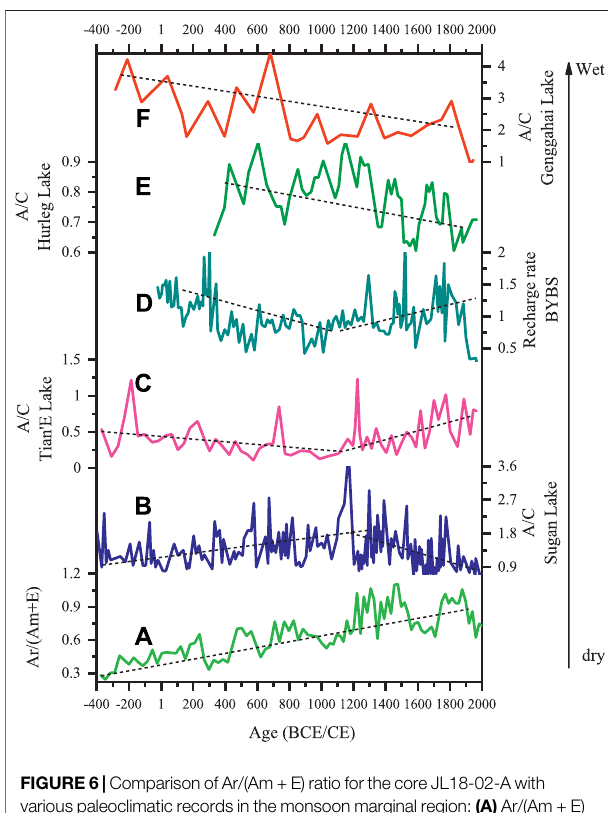
FIGURE6| Comparison ofAr/(Am+E)ratioforthecoreJL18-02-Awith variouspaleoclimatic recordsin the monsoon marginal region: (A) Ar/(Am + E) ratiofrom JiliLake (this study); (B) A/C ratiofrom Sugan Lake (Li, 2020); (C) A/ C ratio from Tian ’ E Lake (Zhang J. et al, 2018); (D) Recharge rate from BYBS pro fi le (Ma et al., 2009); (E) A/C ratio from Hurleg Lake (Zhao et al., 2010); (F) A/C ratio from Genggahai Lake (Liu et al.,